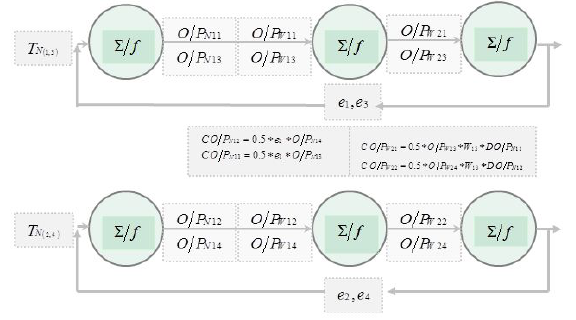
Fig. 4. The proposed wavelet-network